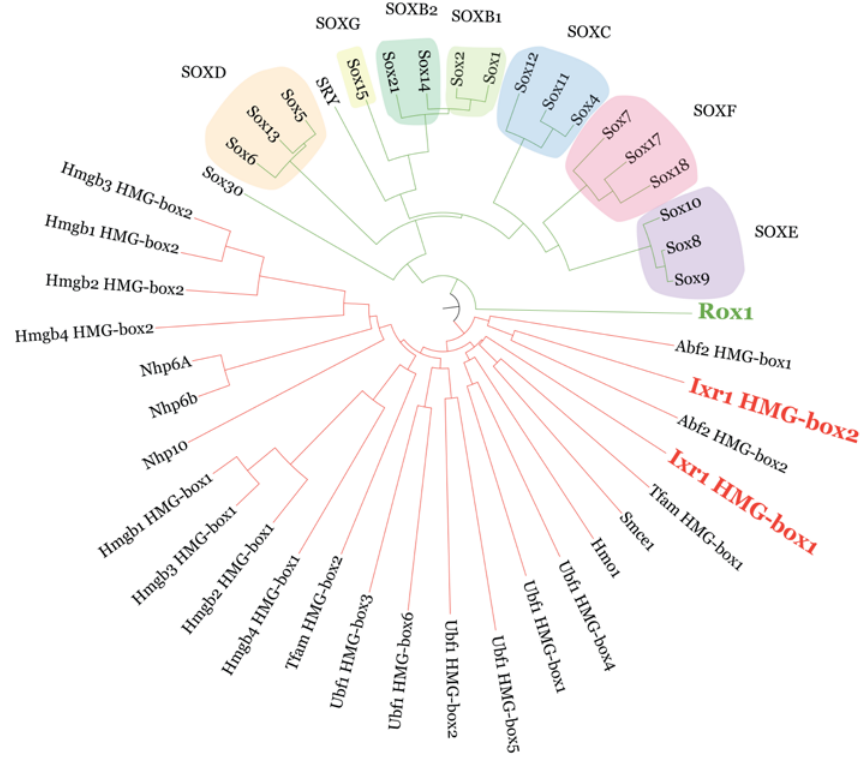
Figure 4. Phylogenetic relations between the HMG-box domains of the yeast proteins Rox1 and Ixr1, and other human HMGB proteins. Phylogeny analysis was made following the Neighbor-joining method (excluding gaps). Output results are available in the Supplementary File